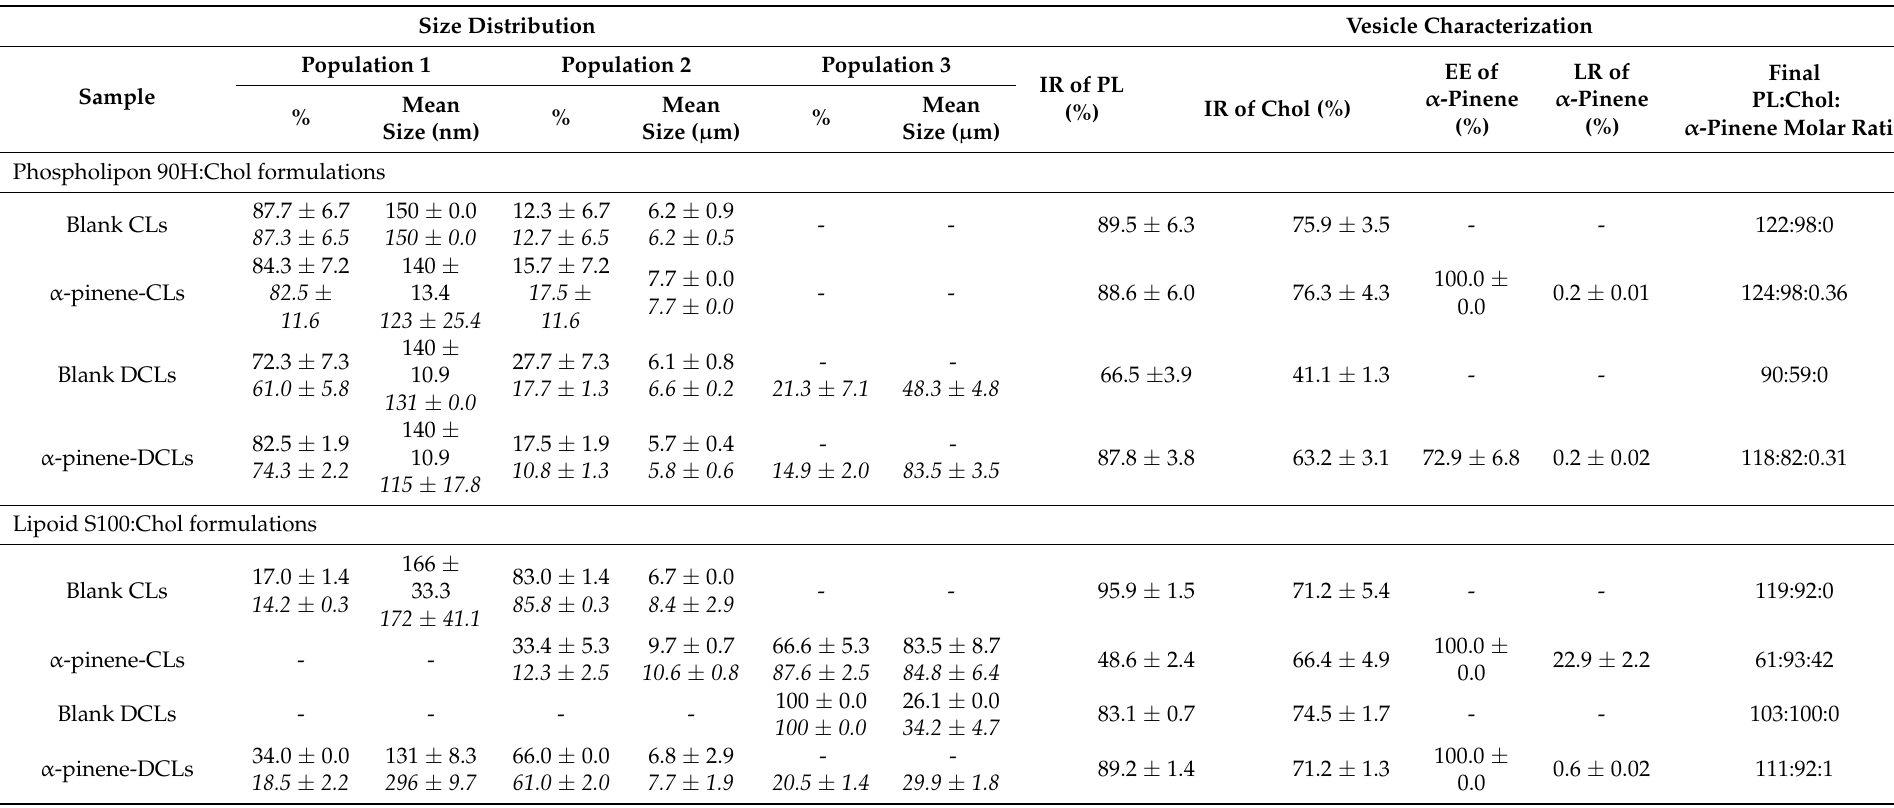
Table 2. Characteristics of blank CLs, α -pinene-CLs, blank DCLs, and α -pinene-DCLs prepared with Phospholipon 90H or Lipoid S100. The values of size in italic are those obtained after 3 months of storage at 4 ◦